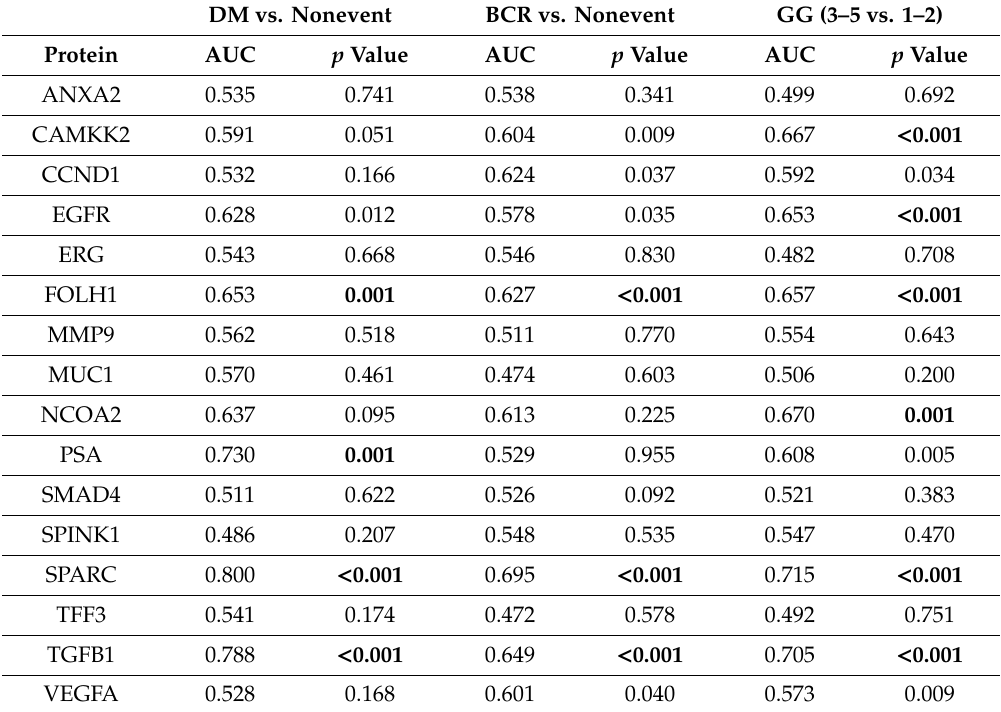
Table 2. Individual area under the receiver-operating characteristic curve (AUC) and p values of 16 proteins to predict distant metastasis (DM), biochemical recurrence (BCR), or high Grade Group (GG): The significant p values ( < 0.003) are shown in bold